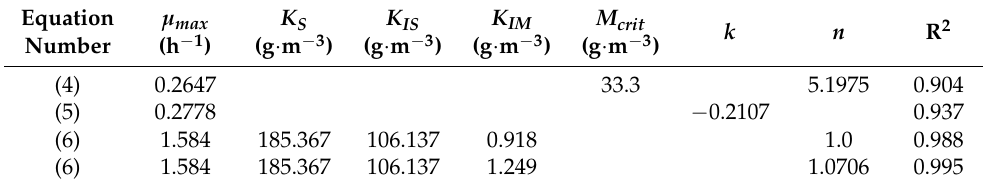
Table 3. Comparison of 3 models of bacterial growth on phenol in the presence of